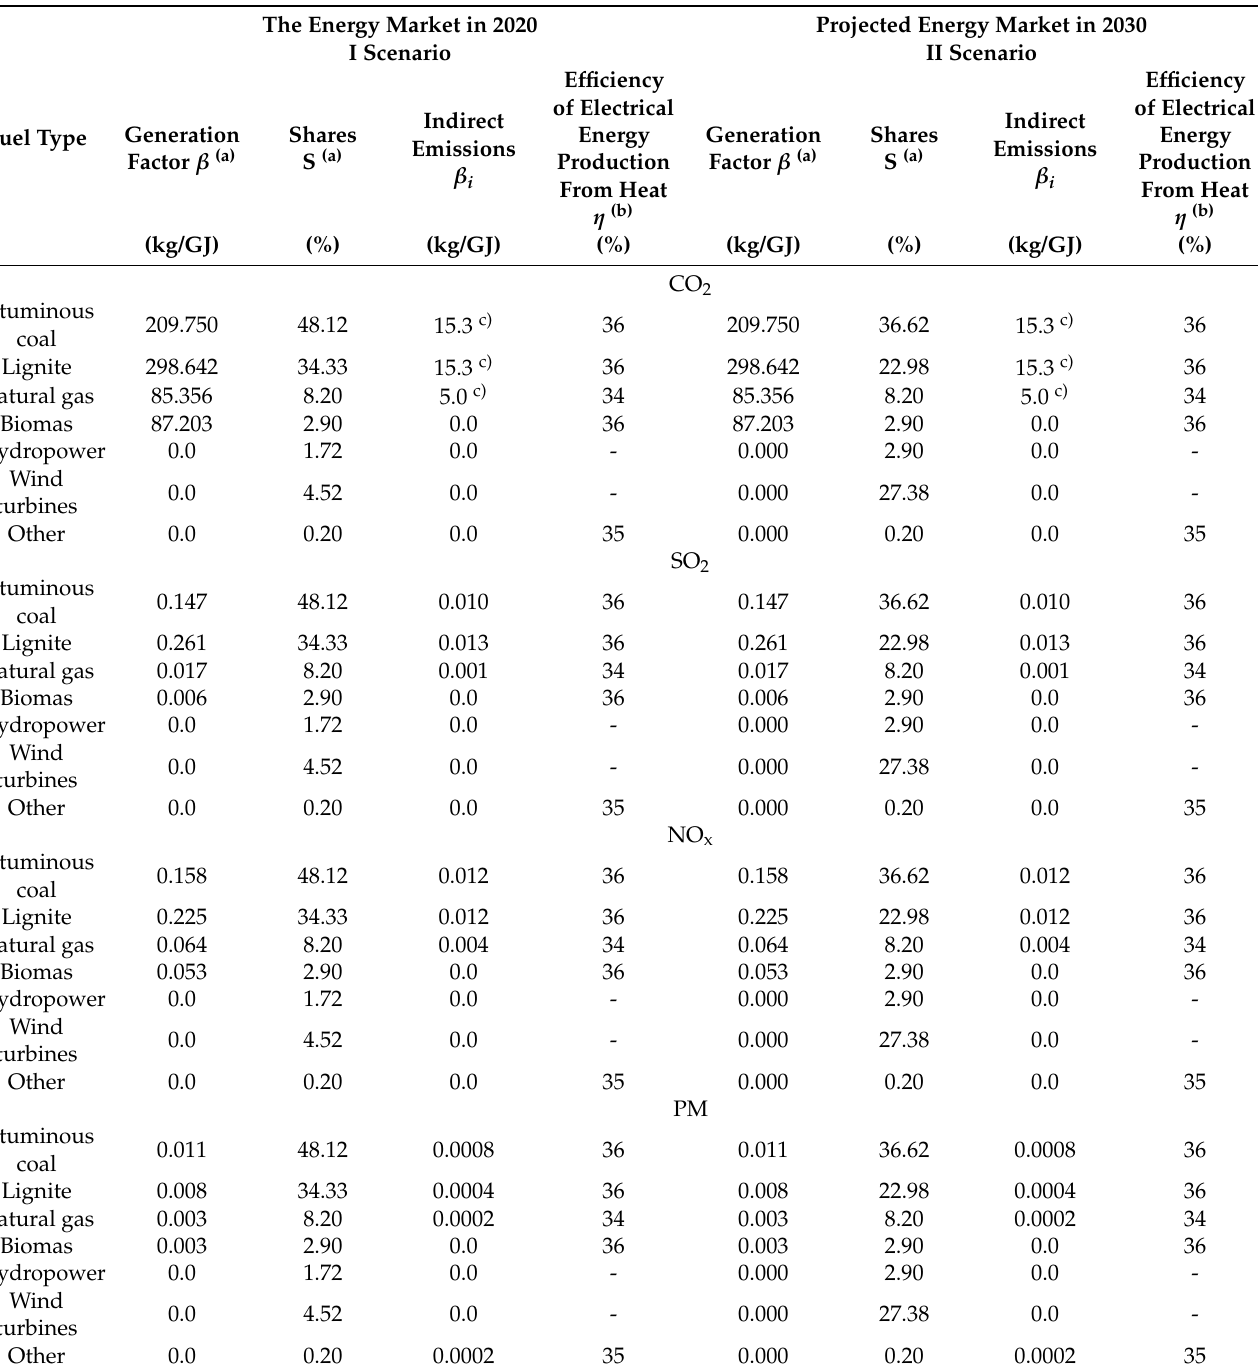
Table 8. The Polish energy mix and the generation